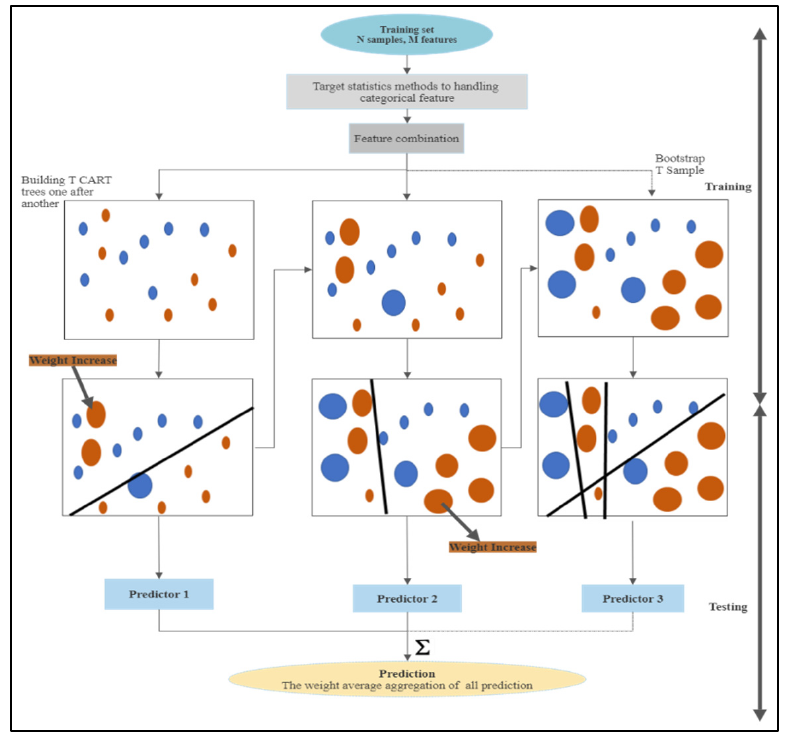
Figure 5. CatBoost (CB) Algorithm Structure.